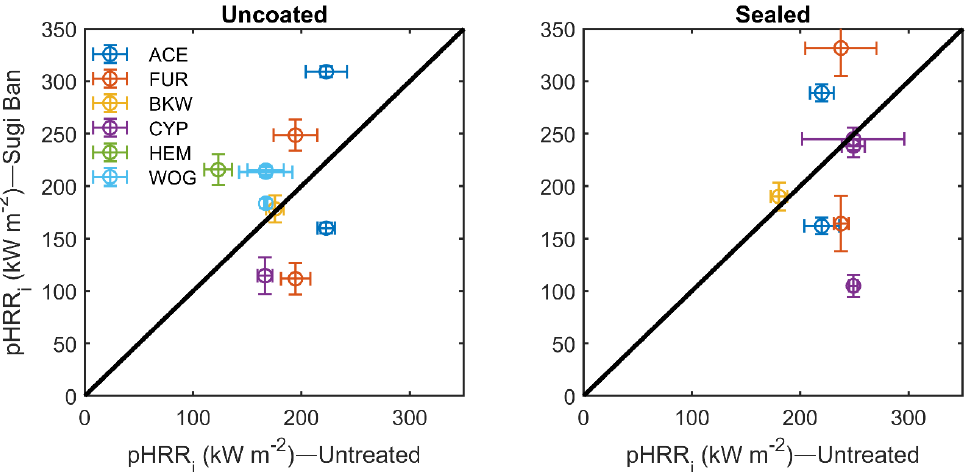
Figure 6. Comparison of the initial peak heat release rate (pHRR i ) between the untreated and charred wood specimens for both the uncoated and sealed specimens. The error bars represent the standard deviation.